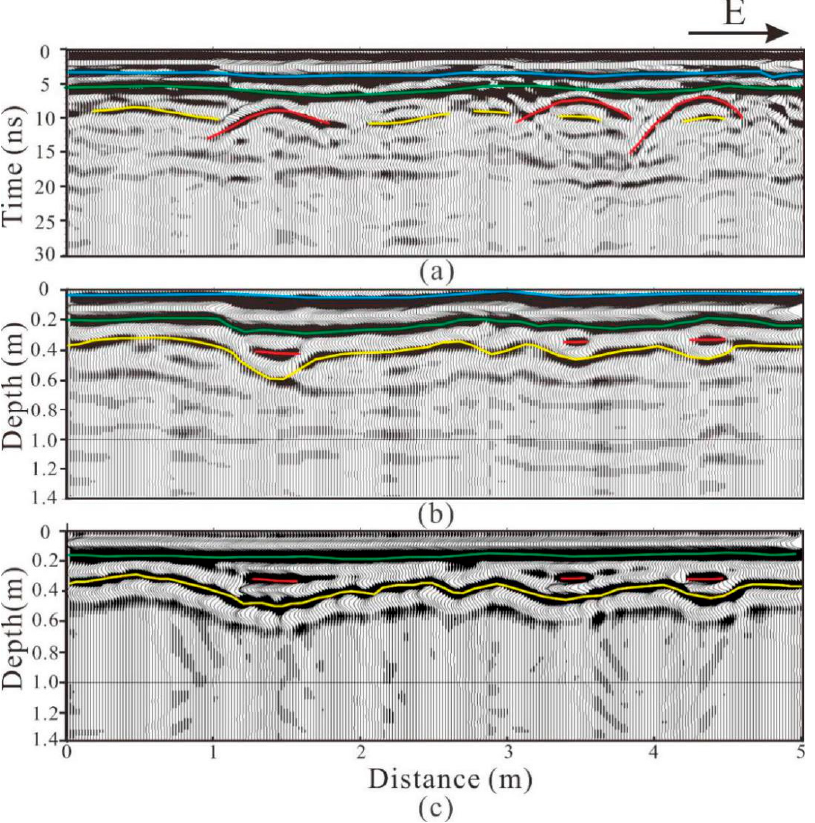
Figure 6. The imaging of migration of L1 line part profile. ( a ) Radar profile; ( b ) real data RTM profile; ( c ) model data RTM profile.